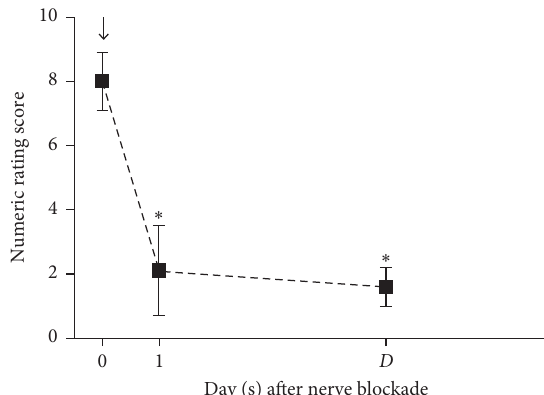
Figure 1: Numeric rating scores in 41 patients before and after occipital nerve blockade. Data at each time point were presented with mean and standard deviation. ↓ : occipital nerve blockade. ∗ , P < 0 . 001 vs. baseline. D: